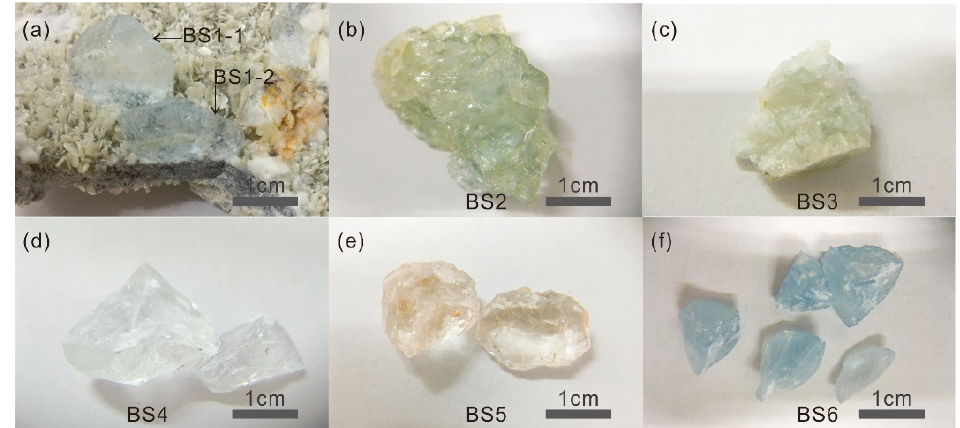
Figure 1. Hand specimens of beryl crystals were used in this study: ( a ) BS1 (including two crystals, BS1-1 and BE1-2) from Sichuan, China; ( b ) BS2 from Norway; ( c ) BS3 from Hunan, China; ( d ) BS4 from Nigeria; ( e ) BS5 from Myanmar; ( f ) BS6 from Brazil.